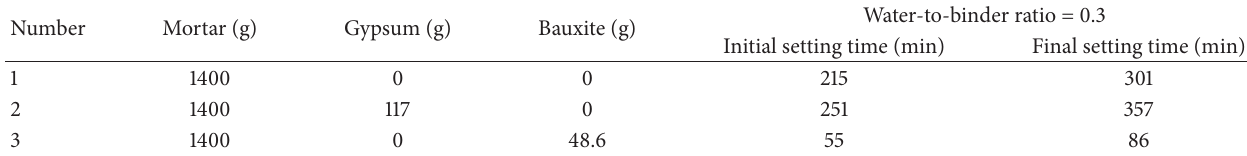
Table 6: Effect of gypsum and bauxite on the setting time of grouting mortar.